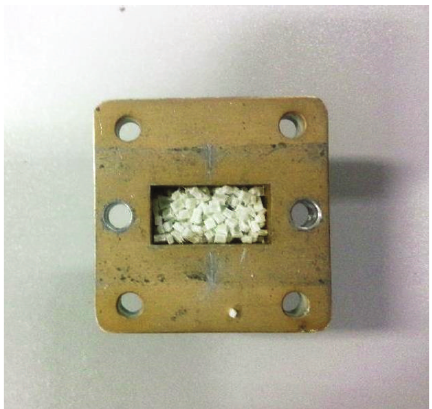
Figure 7: FR4 particles in a rectangular waveguide.